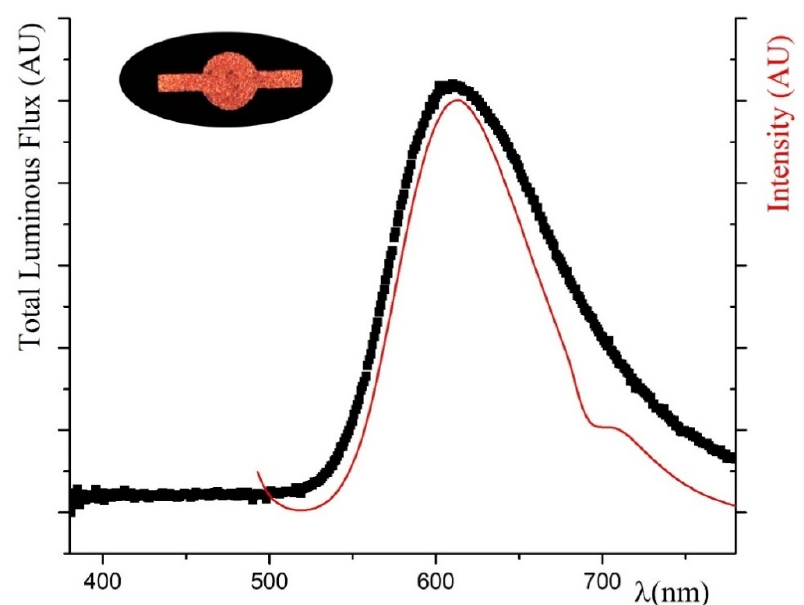
Figure 7. Electroluminescence intensity (normalized) versus wavelength characteristic of the device realized with the 10 wt.% C1-PVK blend. The photoluminescence (PL) spectrum of the same sample is shown in red. The red organic light-emitting device (OLED) is shown in the inset.